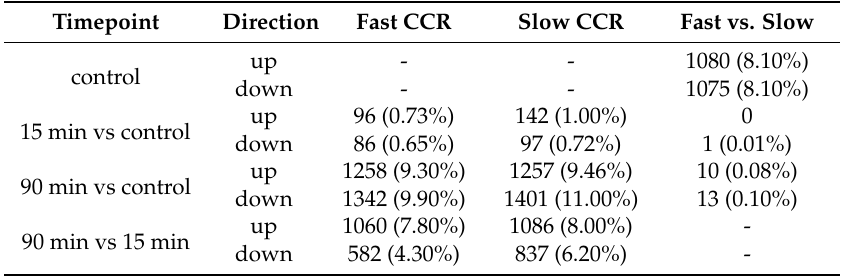
Table 2. Differentially expressed genes in D.